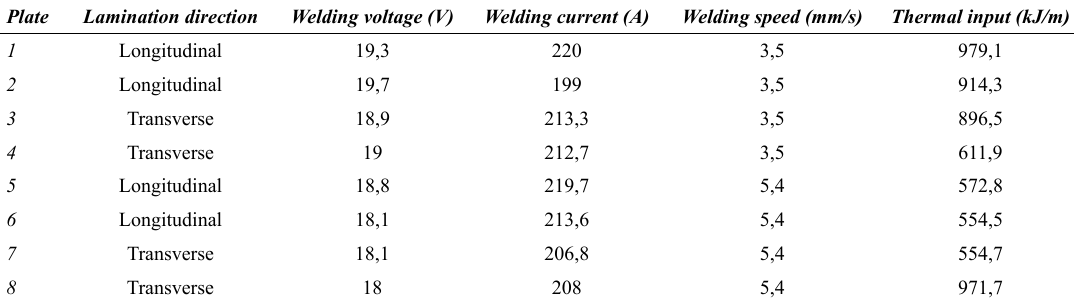
Table 1. Welding parameters used in the welding of the